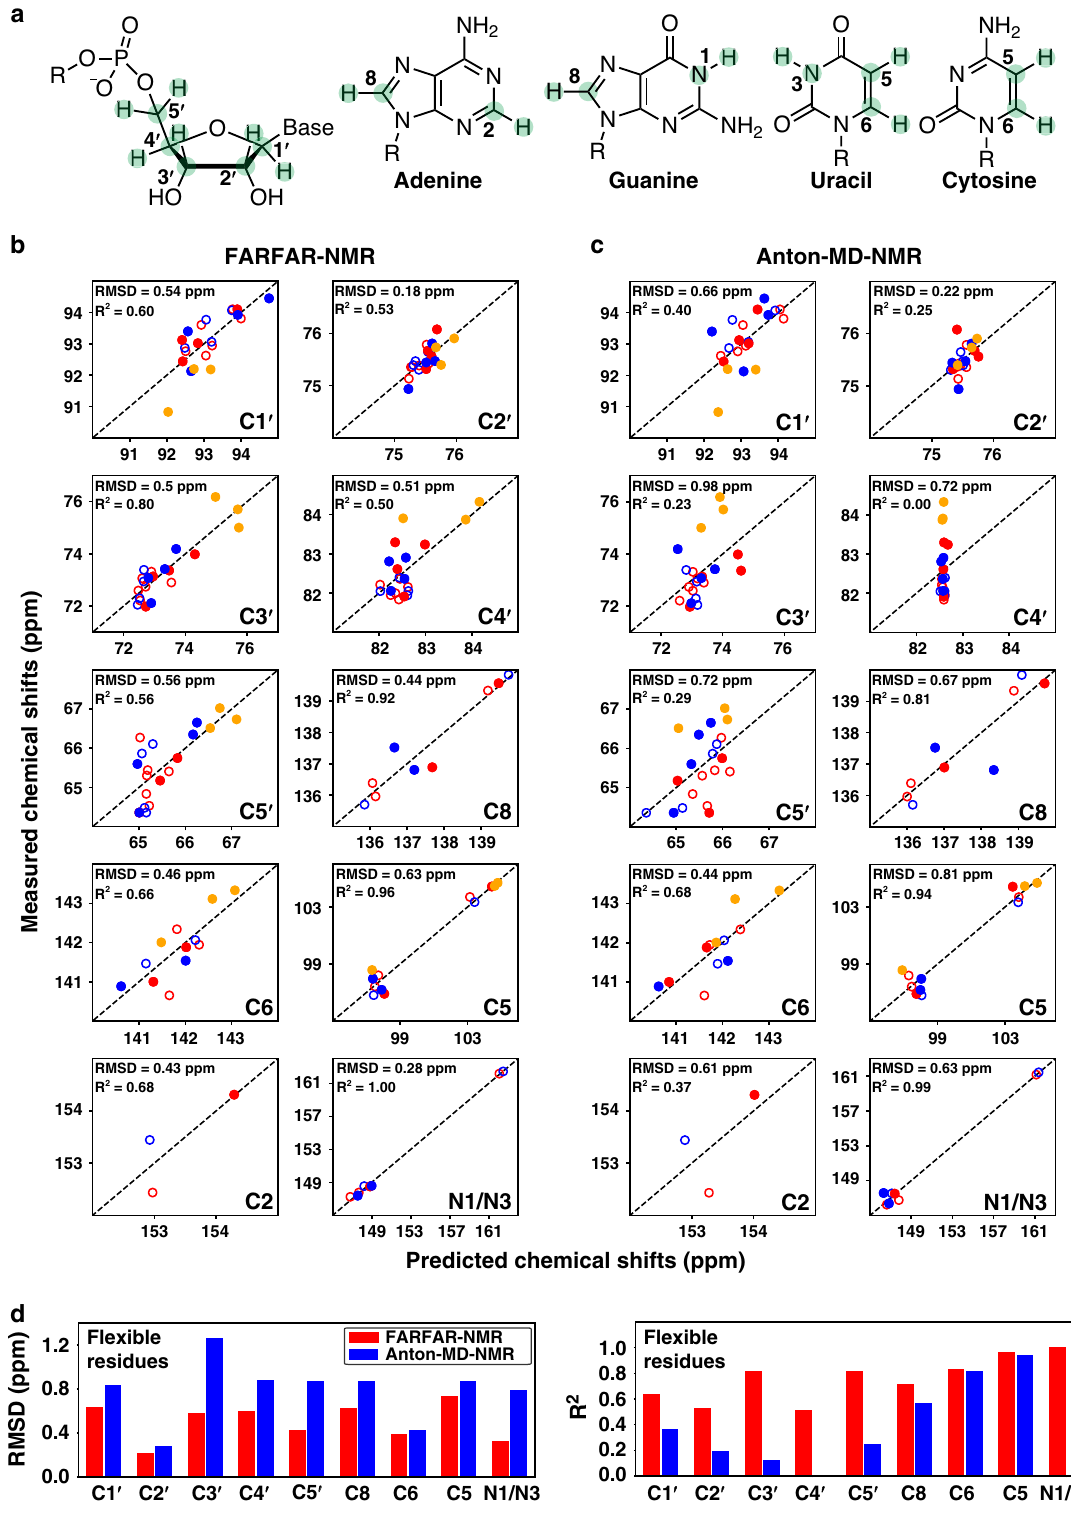
Fig. 3 Evaluating TAR ensembles using chemical shifts. a Chemical structures of the sugar and base moieties with chemical shift probes used to test ensemble accuracy highlighted in green. b , c Comparison of measured and predicted 13 C/ 15 N chemical shifts for b FARFAR-NMR ( N = 20) and c Anton- MD-NMR ( N = 20) by AF-QM/MM ( “ Methods ” ). Values are color-coded according to the structural elements in Fig. 2a. Chemical shifts for central Watson – Crick bps within A-form helices (C19-G43, A20-U42, G21-C41, A27-U38, G28-C37) are denoted using open circles. A correction was applied to the predicted chemical shifts ( “ Methods ” ) as described previously 29 . For 1 H chemical shifts see Supplementary Fig. 3. d Comparison of RMSD (left) and R 2 (right) between measured and predicted 13 C/ 15 N chemical shifts for fl exible residues (U23, C24, U25, A22-U40, G26-C39, C29-G36, G18-C44) for FARFAR-NMR (red) and Anton-MD-NMR